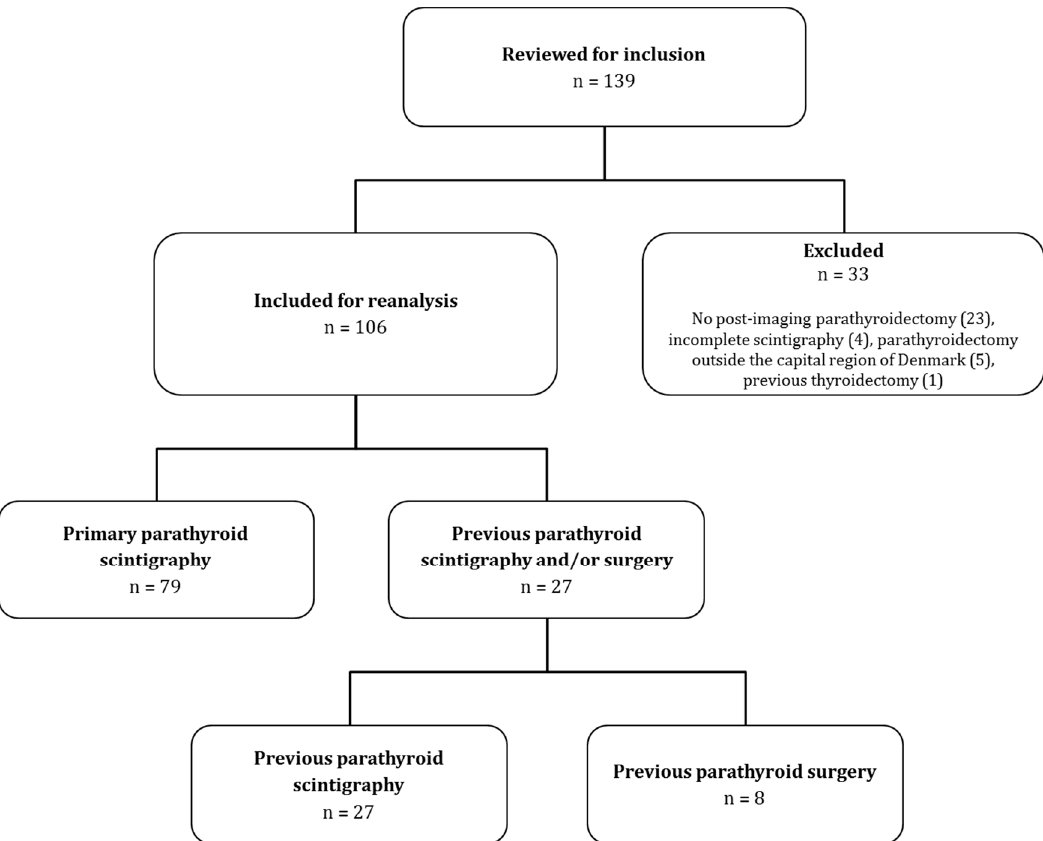
Figure 3. Inclusion flowchart. A total of 106 scintigraphies from between January 1, 2017 and December 31, 2017 were eligible for inclusion. Of these, 79 were primary scintigraphies and in 27 cases patients had undergone previous parathyroid scintigraphy (27) and/or parathyroid surgery (8). Table 1. Baseline patient